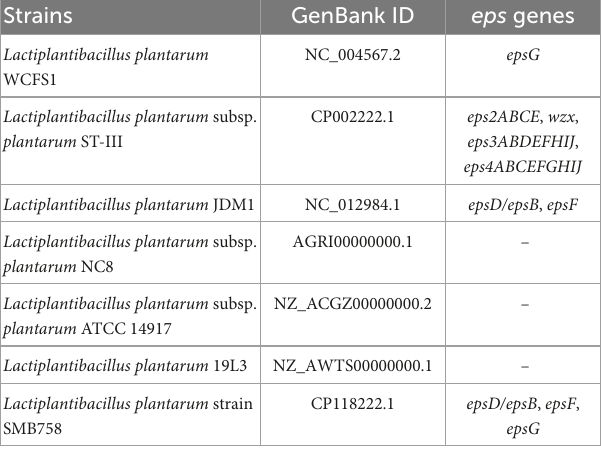
TABLE 1 Genomic information of other lactic acid bacteria.